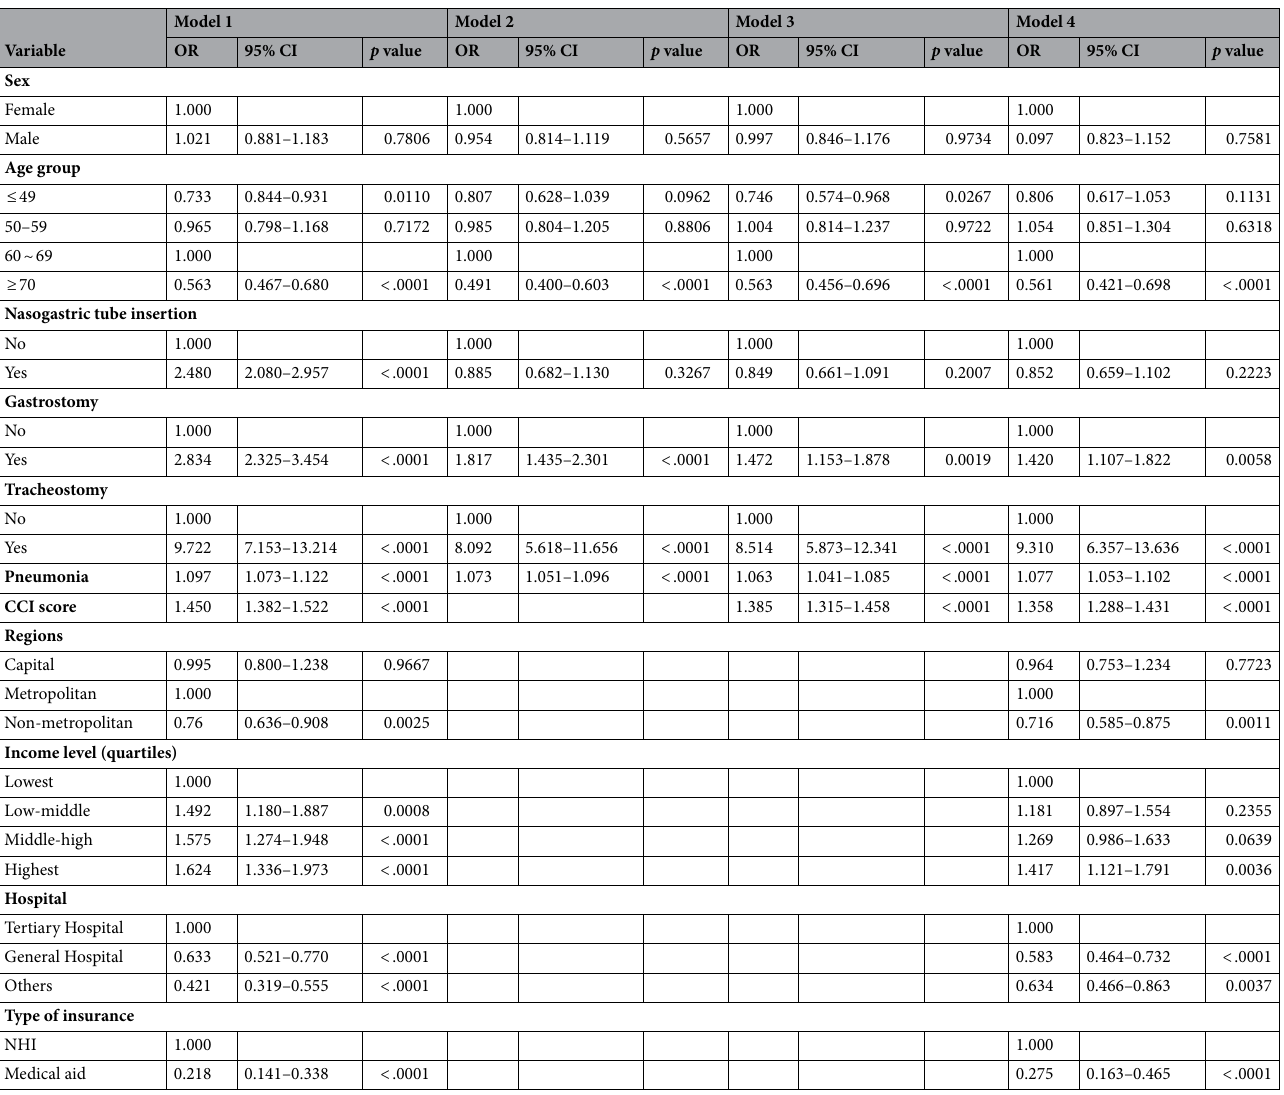
Table 2. Adjusted and unadjusted odds ratio for assisted ventilation in amyotrophic lateral sclerosis. CCI, Charson Comorbidity Index; NHI, National Health Insurance. Model 1: unadjusted. Model 2: adjusted for sex, age, nasogastric tube insertion, gastrostomy, tracheostomy, pneumonia. Model 3: adjusted for sex, age, nasogastric tube insertion, gastrostomy, tracheostomy, pneumonia, CCI score. Model 4: adjusted for sex,